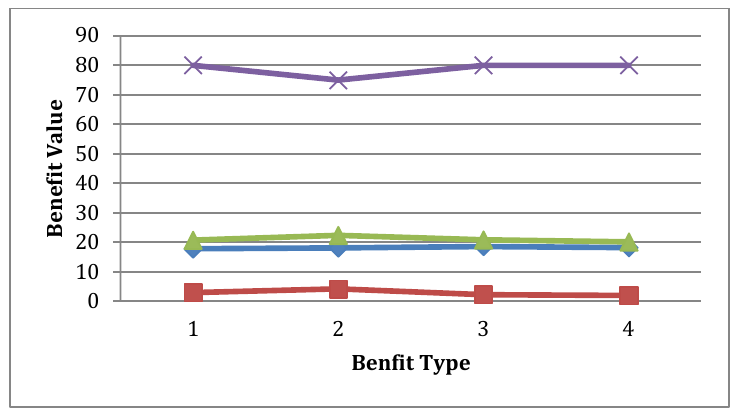
Figure 15: Remanufacturing portfolio based benefit type